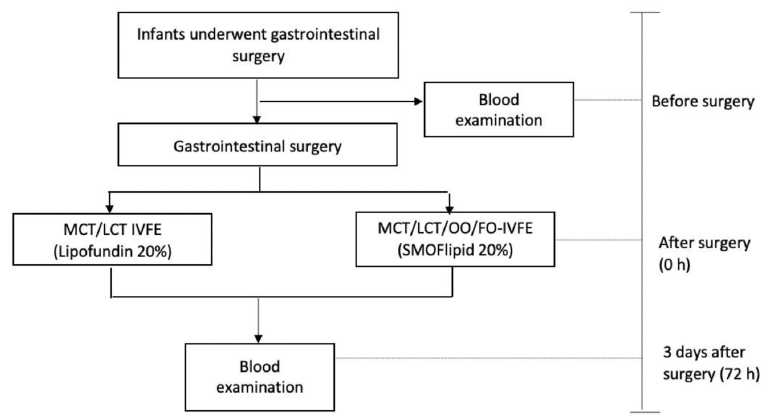
Figure 1. Study flowchart.